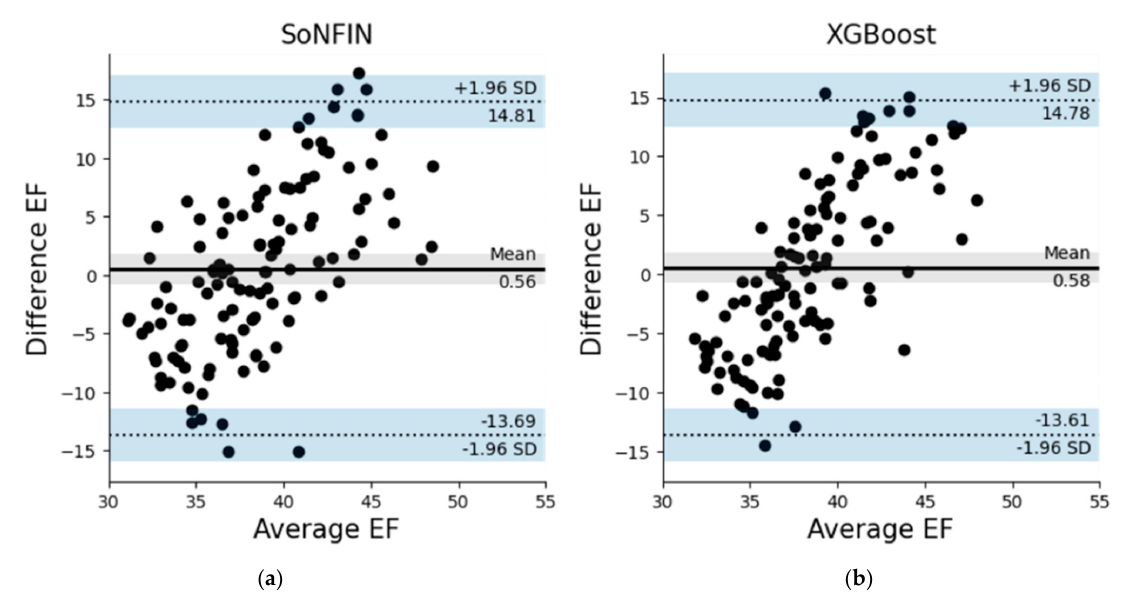
Figure 11. Bland–Altman plots for ( a ) SoNFIN, and ( b ) XGBoost. Table 5. The E RMS of estimated LVEF for 20 patients by SoNFIN and XGBoost within three